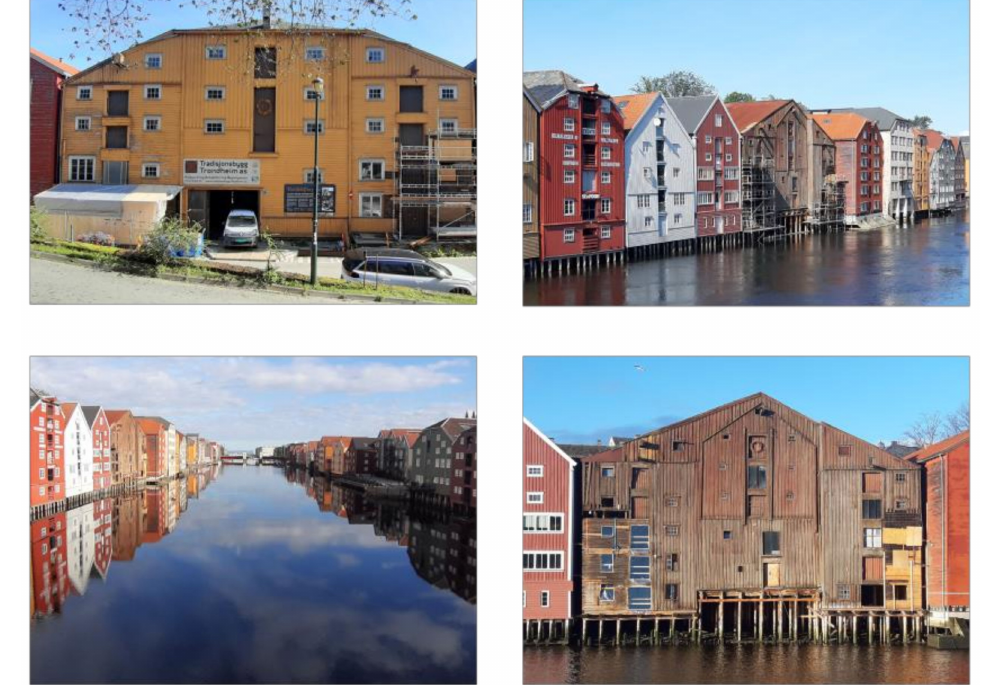
Figure 3. Views of Huitfeldtbrygga in Trondheim, Norway (personal images by the